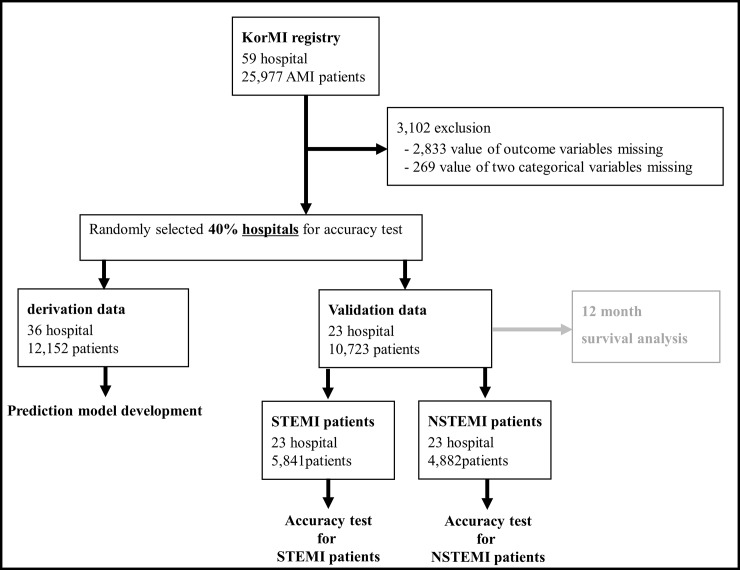
Study flow chart.